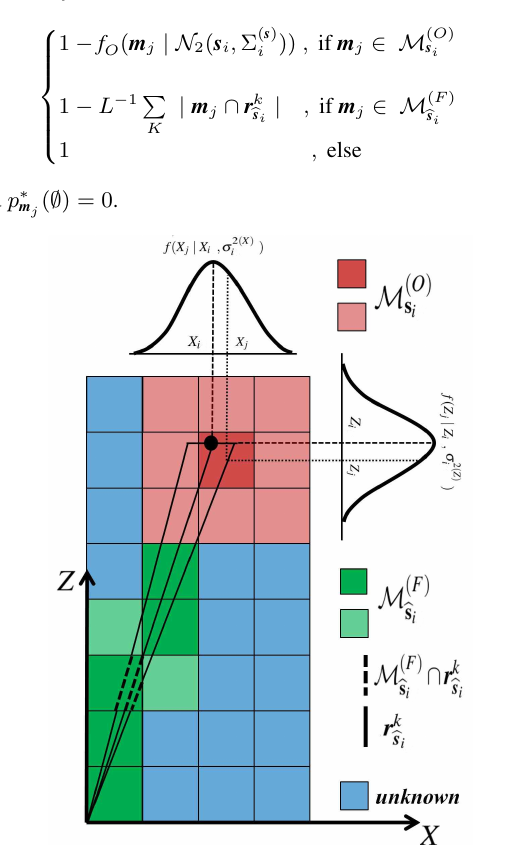
Figure 3: The sensor model of the mapping approach. The cell which is directly hit by a Stixel is dark red, the immediate cell neighbors are bright red. For these cells an evidential value of occupied is estimated which is based on a two dimensional Gaus- sian distribution. The distribution is defined by the position of a Stixel s i = [ X, Z ] i and the covariance matrix Σ ( s ) which in- i cludes the variances σ 2( X ) and σ 2( Z ) . The cells which support i i free regions are green. The more rays pass through a cell the greater is the evidence of free . Cells which are not influenced have an unknown state